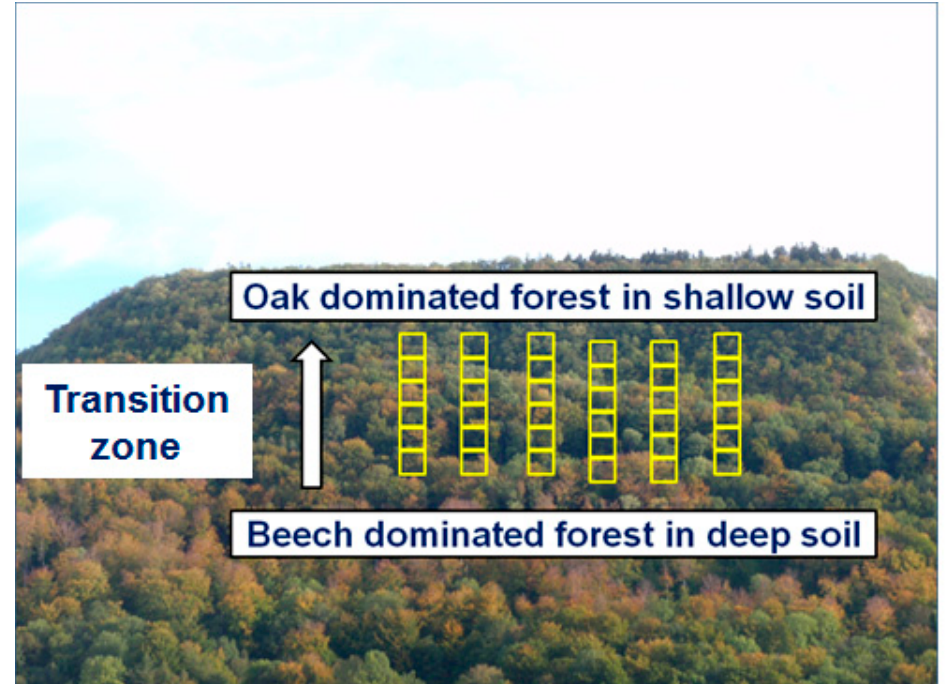
Figure 2. Schematic diagram of continuous plots in the transect, starting from beech dominated forest in deep soil to oak-dominated forest in shallow soil through the transition zone with the heterogeneous soil depth, study site located at Schönberg in the Schwäbische Alb.